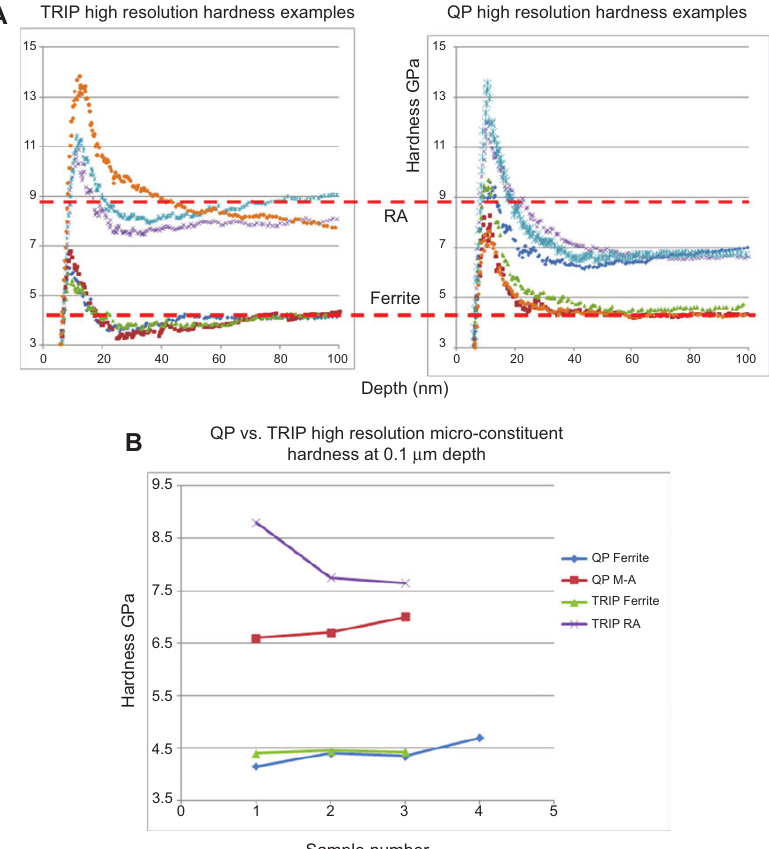
Figure 4 (A) High-resolution continuous hardness measurement for QP vs. TRIP steels. Although the high-resolution ferrite hardness indicated by the lower red dotted line is similar between QP and TRIP, the hardening microconstituent (RA) in QP has a comparatively lower hardness. (B) High-resolution hardness of the various microconstituents including ferrite grains, TRIP residual austenite (RA) and QP martensite-retained austenite